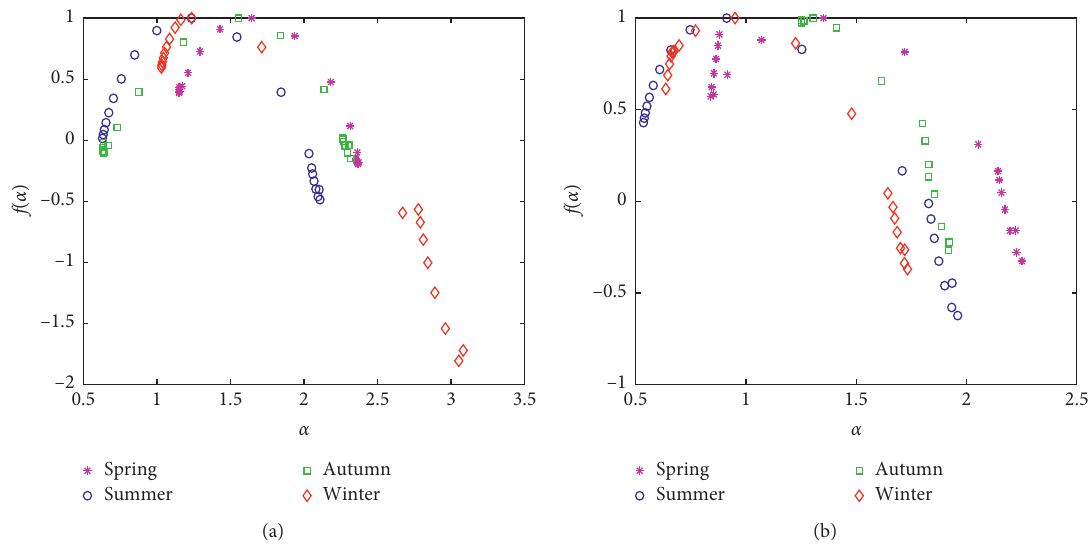
Figure 5: Holder exponent of (a) PM